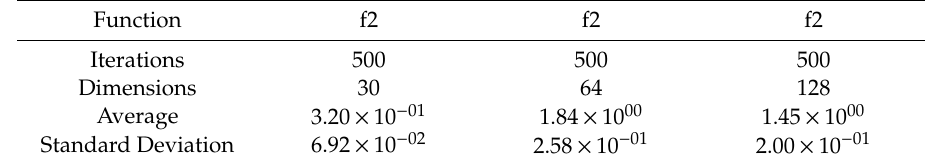
Table 13. Results for f2 with FA.